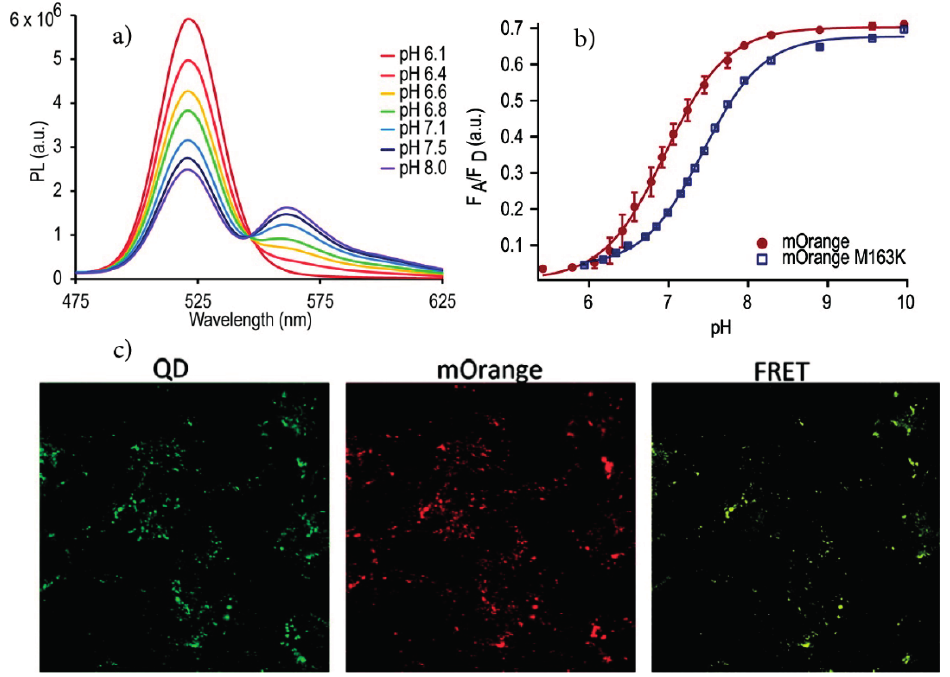
Figure 7. ( a ) QD-mOrange FP probe emission modulation as a function of pH; ( b ) pH-dependent integrated acceptor to donor emission ratio; ( c ) Fluorescence microscopy images after delivery of the sensor using filter sets to image the QDs separately from the pH sensitive FP. (Reprinted with permission from [86], Copyright 2012 American Chemical